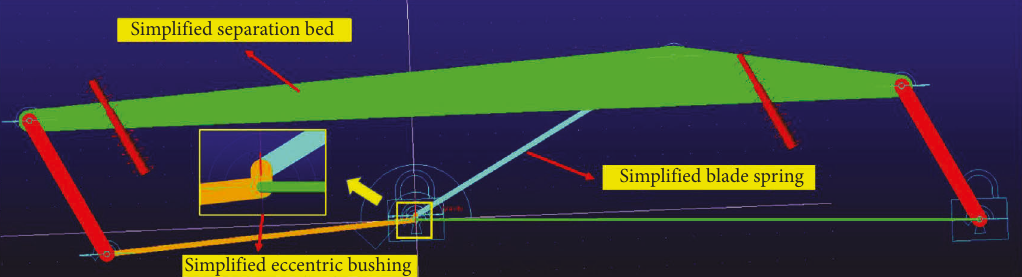
Figure 3: Simulation model of the NCDS.